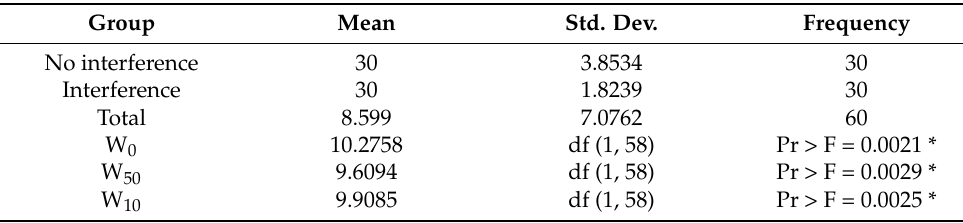
Table 5. Levene’s test of the homogeneity of variance in upload measurements.